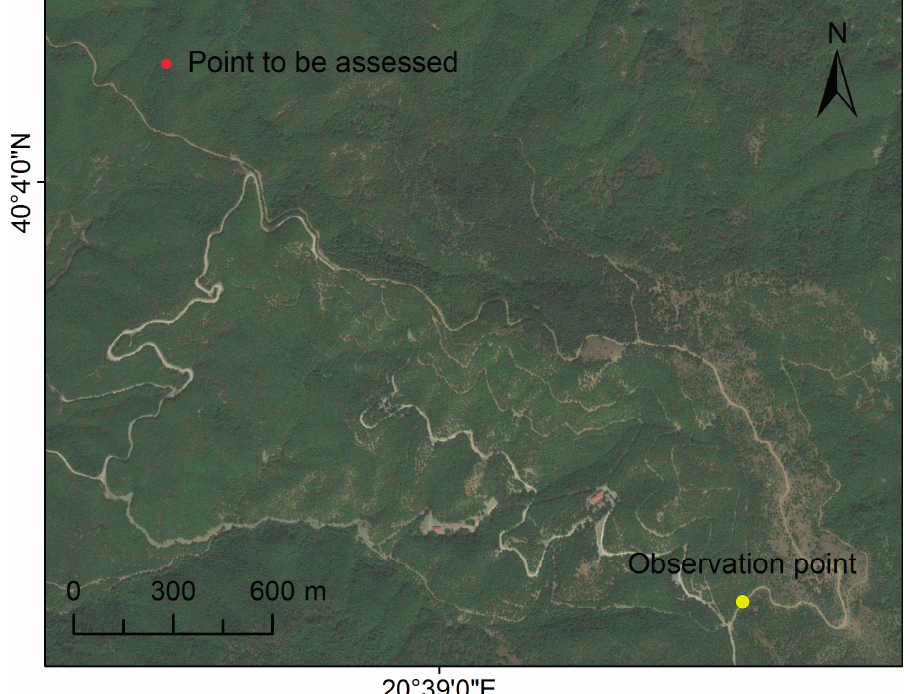
Figure 12. A particular case in Ioannina, where identification of “Mixed Woodland” (C30) was attempted by the LUCAS surveyors from a distance longer than 2 km, although available forest roads closer to the point could provide a safer